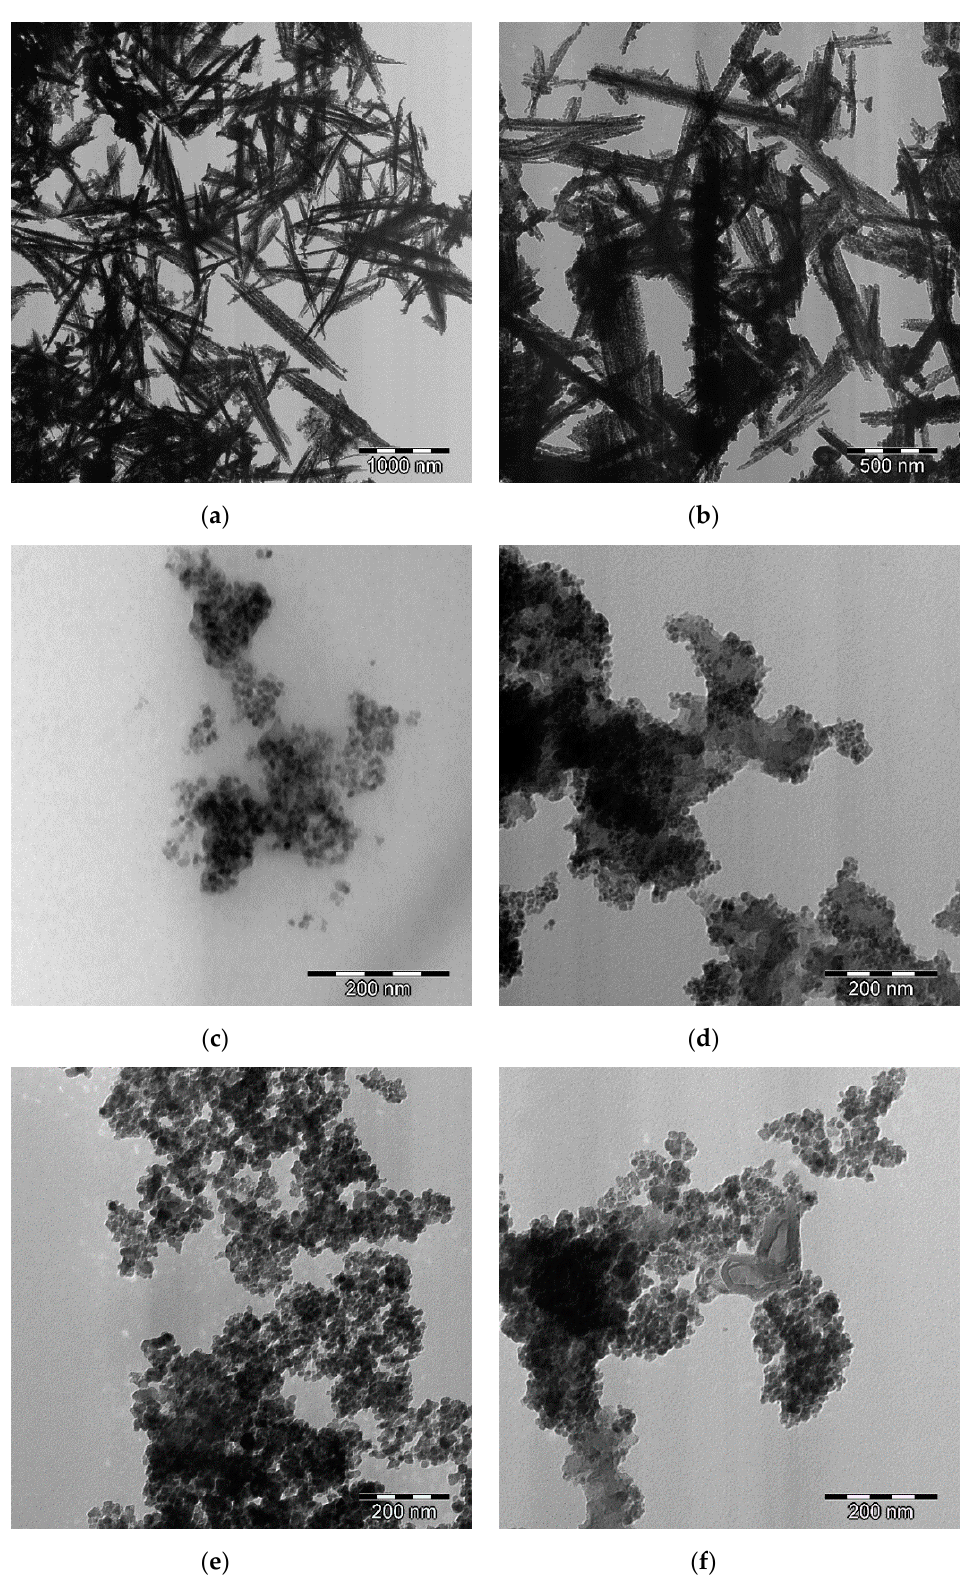
Figure 4. High resolution transmission electron microscopy (HRTEM) images for ( a ) NiCo 2 O 4 / Co-CX, ( b ) NiCo 2 O 4 / Ni-CX, ( c ) NiFe 2 O 4 / Co-CX, ( d ) NiFe 2 O 4 / Ni-CX, ( e ) CoFe 2 O 4 / Co-CX, and ( f ) CoFe 2 O 4 / Ni- CX.